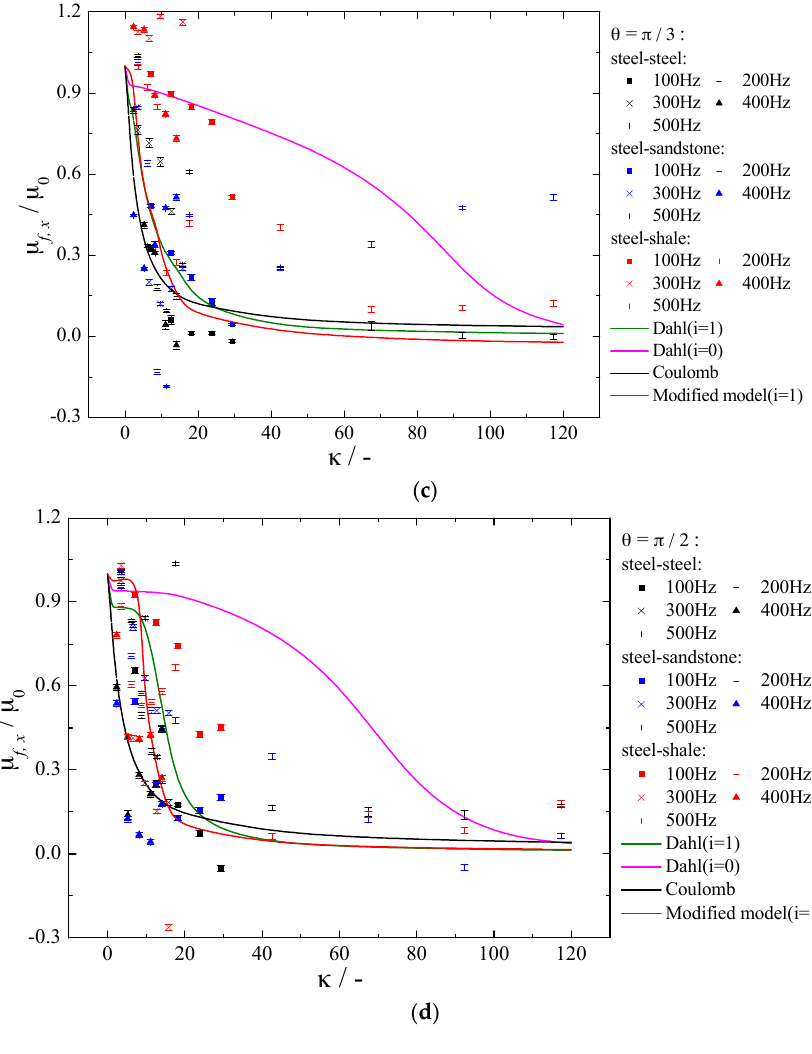
Figure 12. The effect of velocity ratio and vibration direction on friction coefficient ratio. ( a ) θ = 0 ; ( b ) θ = π/6 ; ( c ) θ = π/3 and ( d ) θ = π/2 .